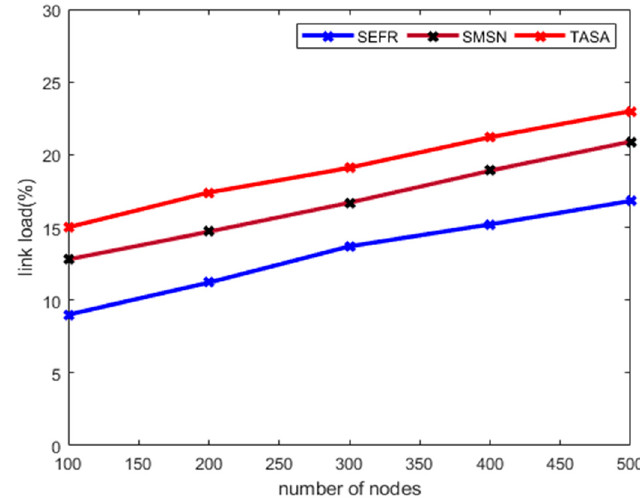
Figure 7. Link load with varying number of nodes.